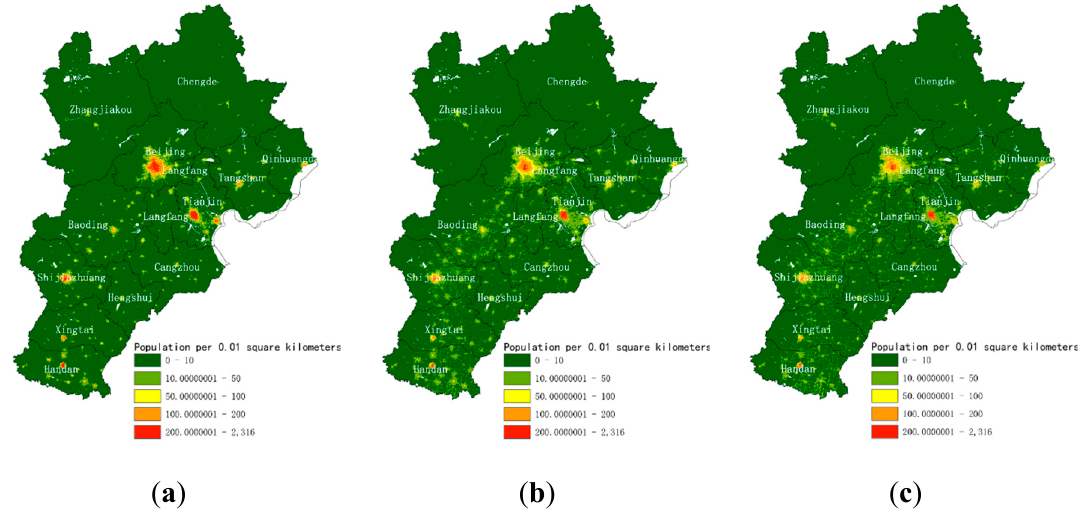
Figure 8. Fine-grained population map driven by the dasymetric model driven by PSP, all POI records, and no POI. ( a ) PSP ( b ) All POI ( c ) no POI. Table 4. Accuracy assessment of the dasymetric model driven by PSP, all POI records, and no POI. Dataset All